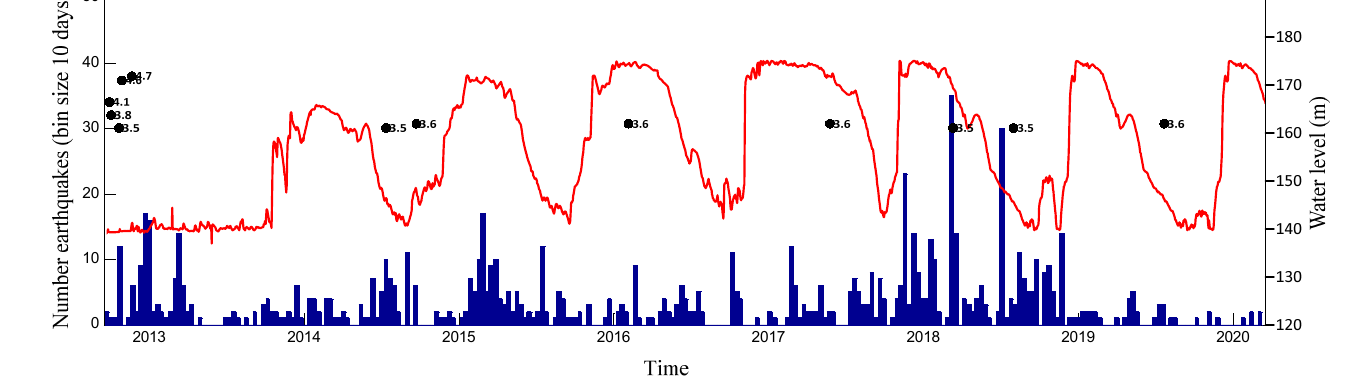
Figure 5. Temporal variation in water level in the ST2 reservoir (red) and number of earthquakes (ML ≥ 1.7) per 10 days (blue) in the period of September 2012 to March 2020. Black dots show the time occurrence of earthquakes (ML ≥ 3.5).